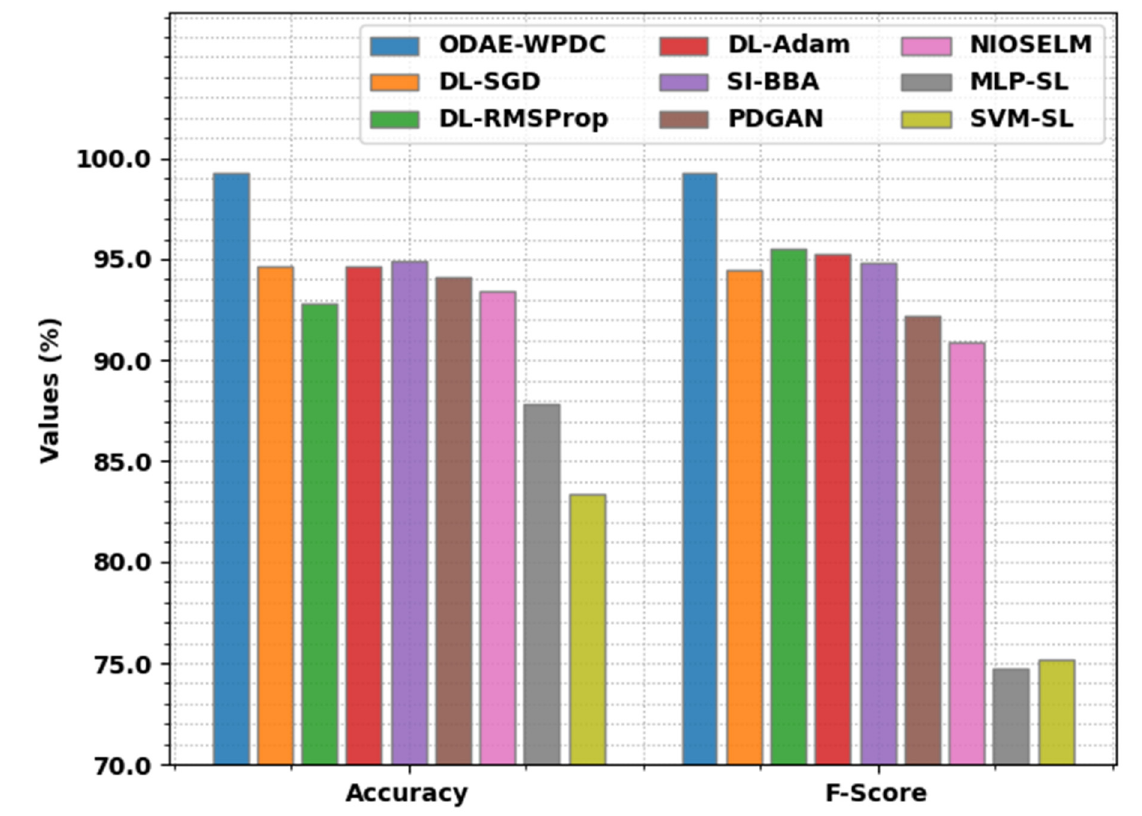
Figure 9. Accu y and F score analysis of ODAE-WPDC approach with existing Figure 9. 𝐴𝑐𝑐𝑢 (cid:3052) and 𝐹 (cid:3046)(cid:3030)(cid:3042)(cid:3045)(cid:3032) analysis of ODAE ‐ WPDC approach with existing methodologies